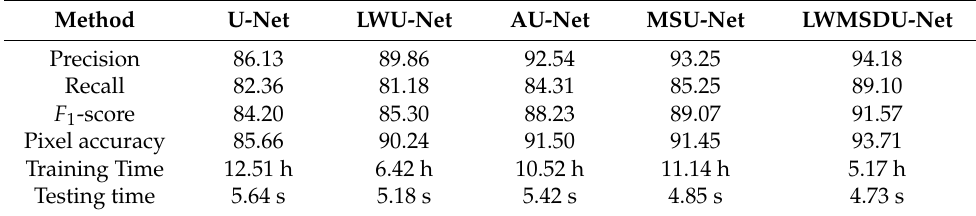
Figure 10. Typical segmented disease leaf images by 5 models. To be fair, 5 trained models are chosen after the 3000th iteration. The typical seg- mented disease leaf images of five models are shown in Figure 10. From Figures 9 and 10, it is observed that all four modified U-Net models are much better than the traditional U-Net. In five-fold cross verification experiments, the trained U-Net, LWU-Net, AU-Net, MSU-Net and LWMSDU-Net are used to segment the disease